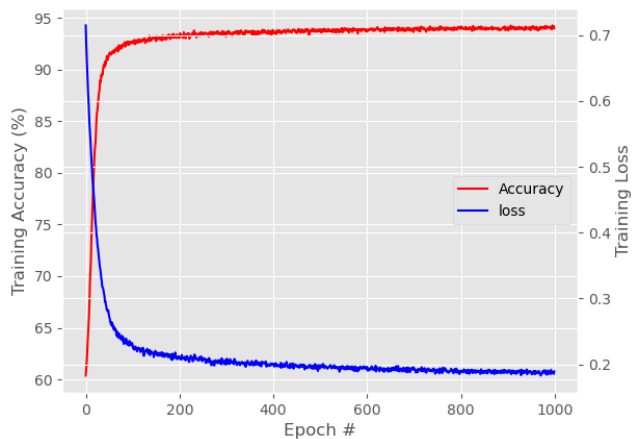
Figure 16. Graph of training accuracy and loss for stacked LSTM with L =